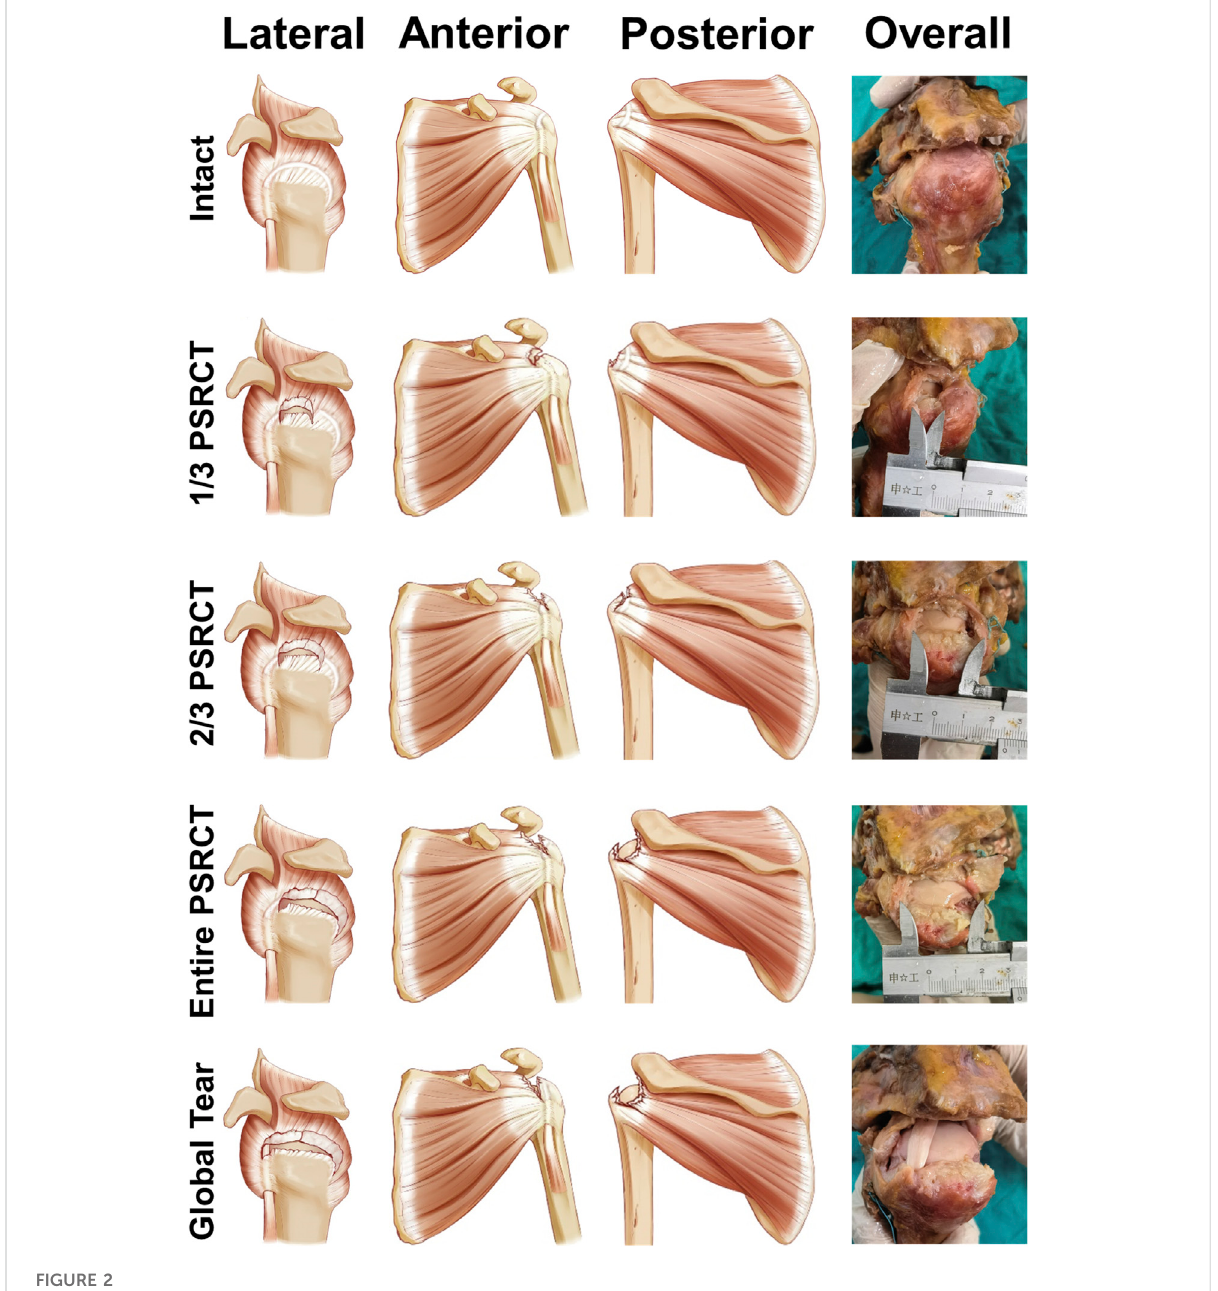
FIGURE 2 Schematic graph of the testing